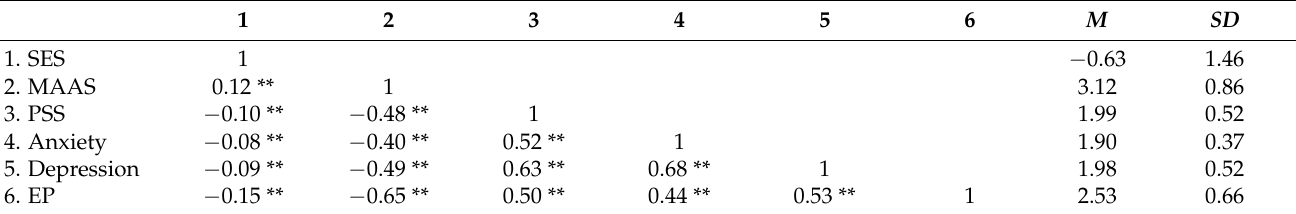
Table 2. Correlations, means, and standard deviations of variables ( n =